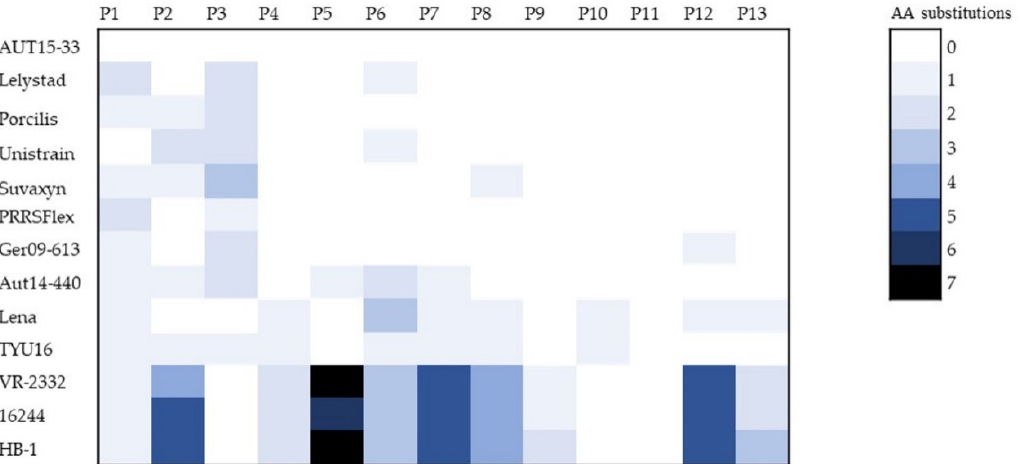
Figure 6. Heat map illustrating conservation of isolated AUT15-33 peptides compared to other PRRSV vaccine strains (94881: Ingelvac PRRSFLEX EU; DV: Porcilis PRRS, MSD; Amervac: Unistrain PRRS, HIPRA; 96V198: Suvaxyn PRRS MLV, Zoetis), PRRSV-1, and PRRSV-2 (VR-2332, 16244, HB-1) isolates. Numbers of amino acid substitutions are coded according to the color key. P, peptide; AA, amino